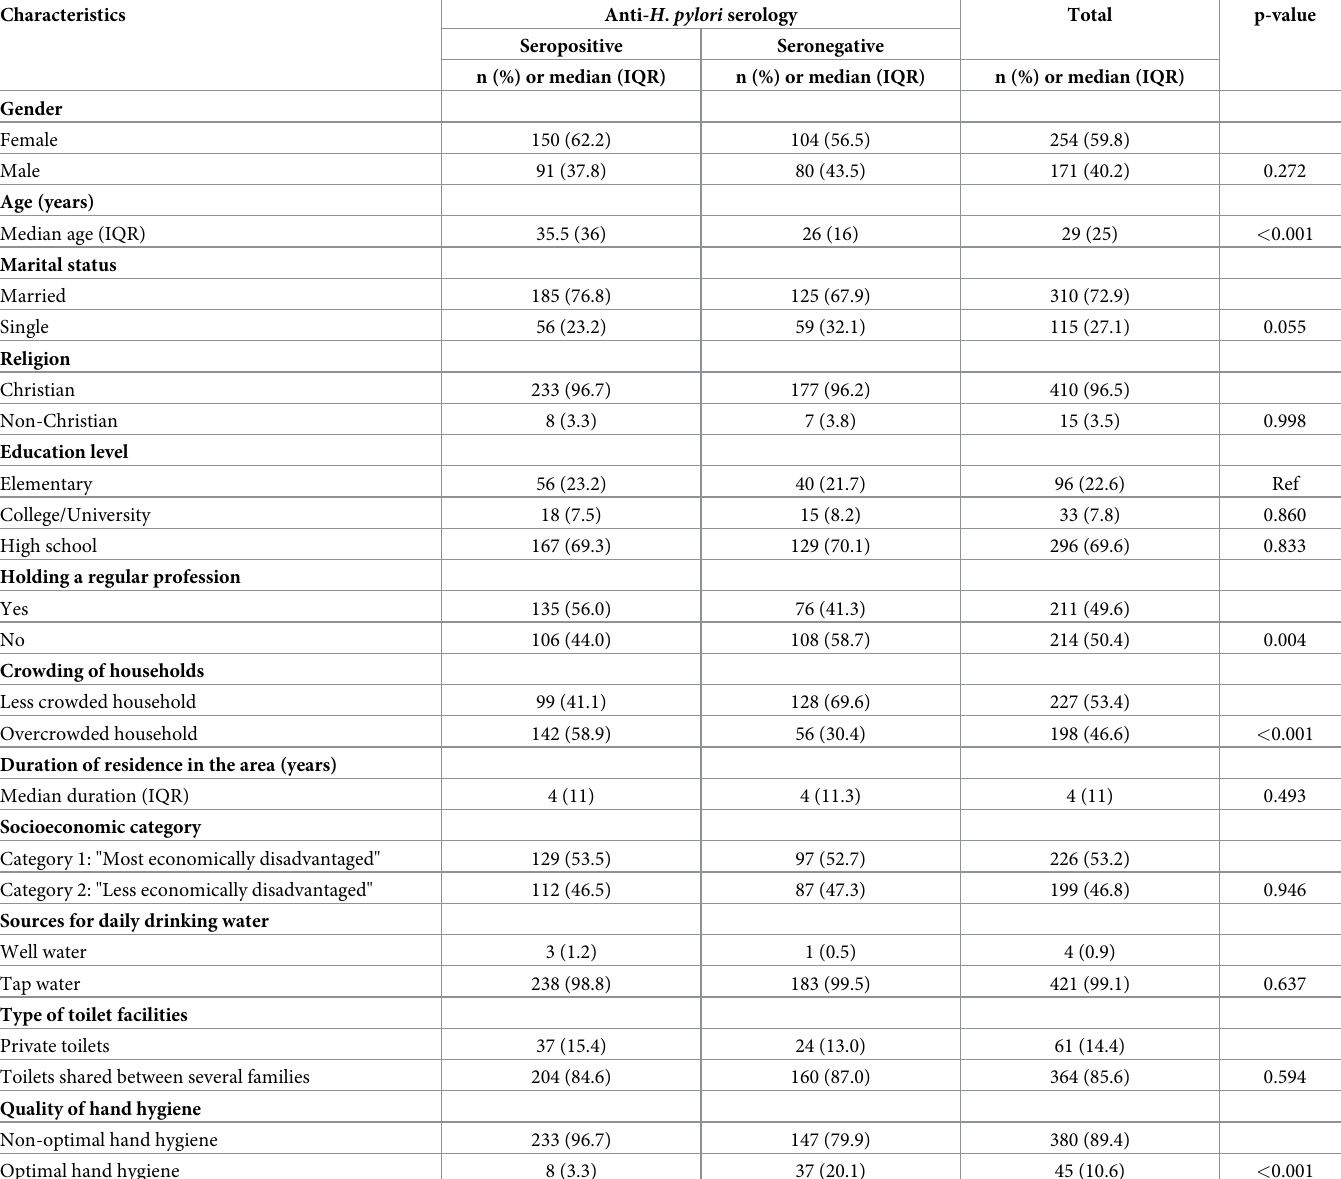
Table 5. Baseline socio-demographic characteristics of study participants (n =